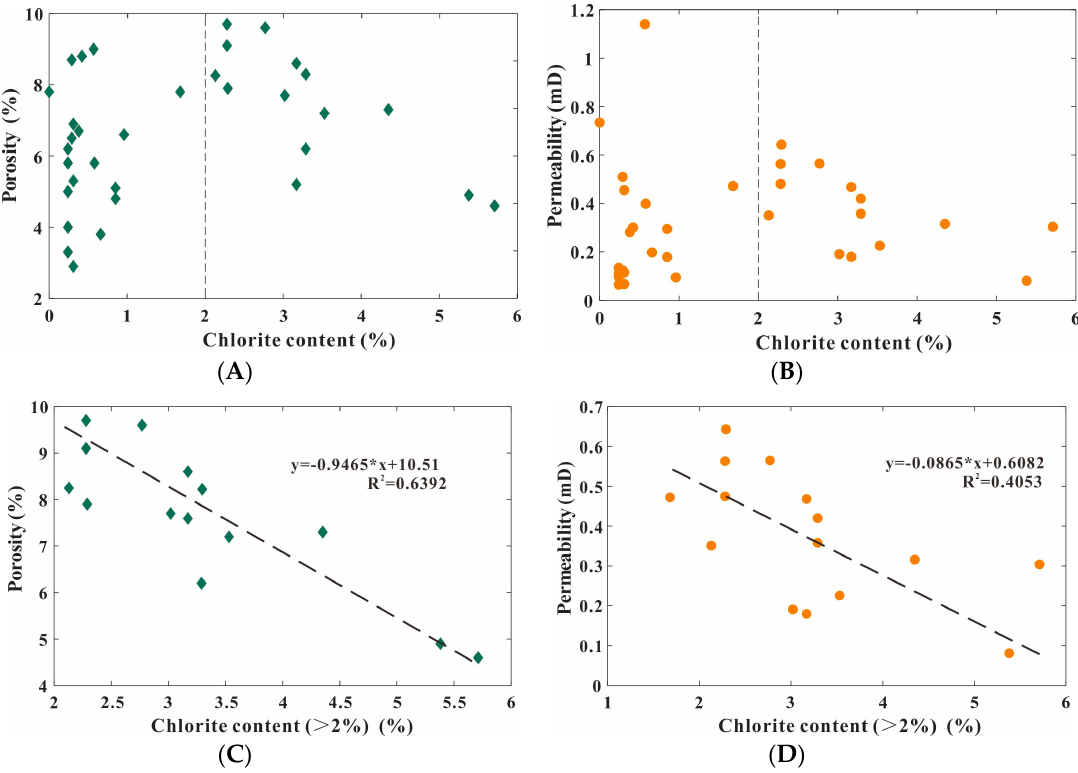
Figure 15. The relation between Chlorite content (%) based on X-ray diffraction analysis and Porosity (%) or Permeability (mD). ( A ) the relation between Chlorite content (%) based on X-ray diffraction analysis and Porosity (%); ( B ) the relation between Chlorite content (%) based on X-ray diffraction analysis and Porosity (%); ( C ) the relation between Chlorite content (>2%) (%) based on X-ray diffraction analysis and or Permeability (mD); ( D ) the relation between Chlorite content (>2%) (%) based on X-ray diffraction analysis and Permeability (mD).